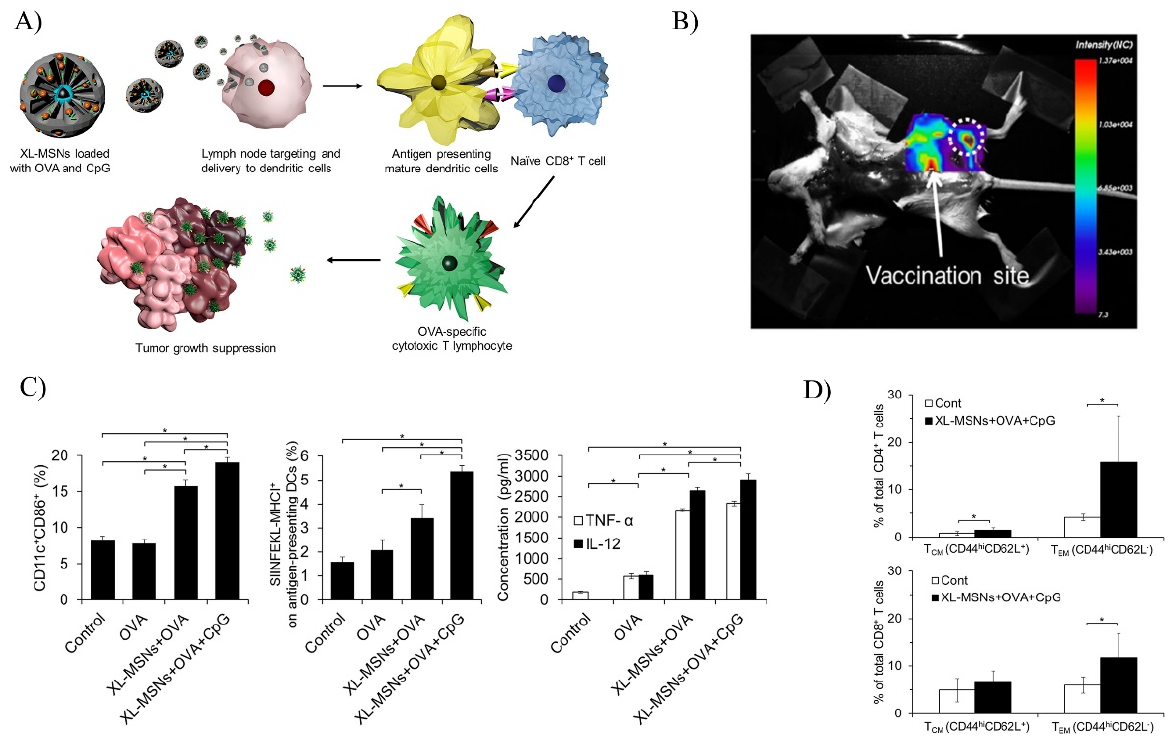
Figure 5. An extra-large pore MSN platform for co-delivery of antigen and agonist. ( A ) A schematic of the fabrication and vaccination process of the extra-large pore MSN (XL-MSN) co-loaded with antigen ovalbumin (OVA) and toll-like receptor 9 agonist CpG. ( B ) Fluorescence imaging of mouse injected with RITC-labeled XL-MSN. Shows accumulation of nanoparticles towards the lymph nodes. ( C ) Percentage of activated CD11c + CD86 + BMDCs and percentage of BMDCs presenting antigenic SIINFEKL peptide on the MHC-molecule. Analysis was through flow cytometry. Concentrations for secreted cytokines TNF- α and IL-12 from BMDCs measured by ELISA. ( D ) Memory T cell population for CD4+ and CD8+ T cells of vaccinated mice measured by flow cytometry. Error bars, mean ± s.d., * p < 0.05. Reprinted (adapted) with permission from Ref. [123]. Copyright 2021, American Chemical Society.